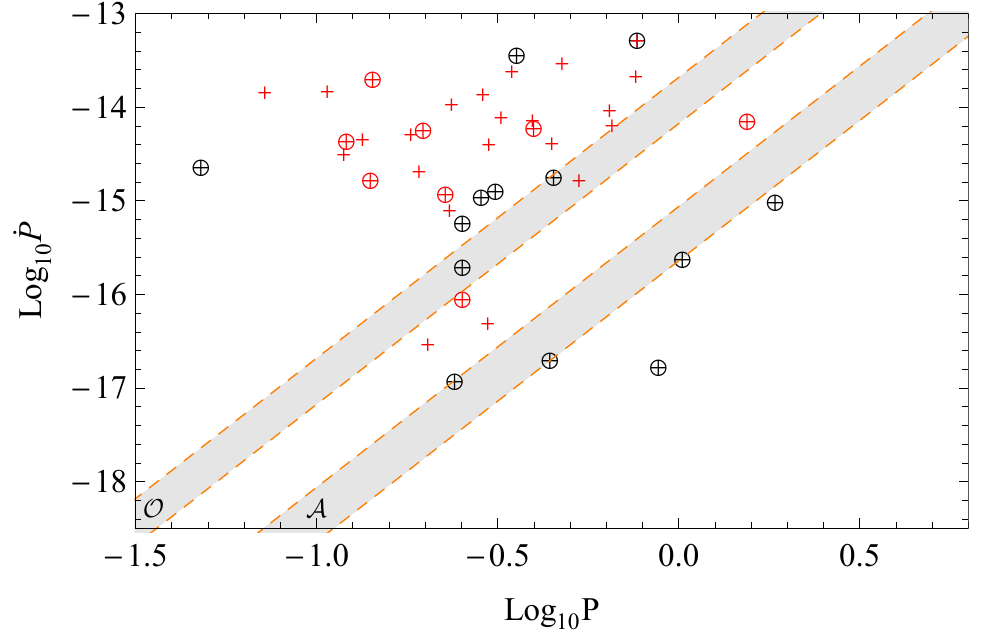
Figure 3. Pulsars (not necessarily nulling or intermittent) exhibiting interpulses of both double- pole (red crosses; almost orthogonal rotators) and single-pole (black circled crosses; almost aligned rotators) as compiled by [35] (with data originally from [39–51]), as well as [52]. The red circled crosses are pulsars for which [35,52] made opposite single or double-pole